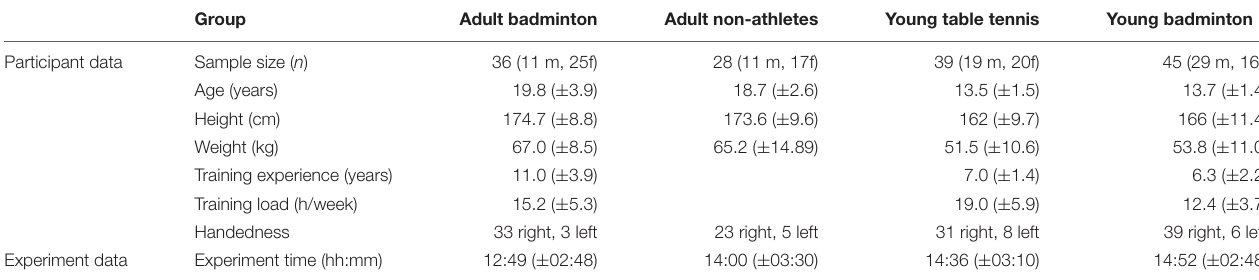
TABLE 1 | Summary of participant